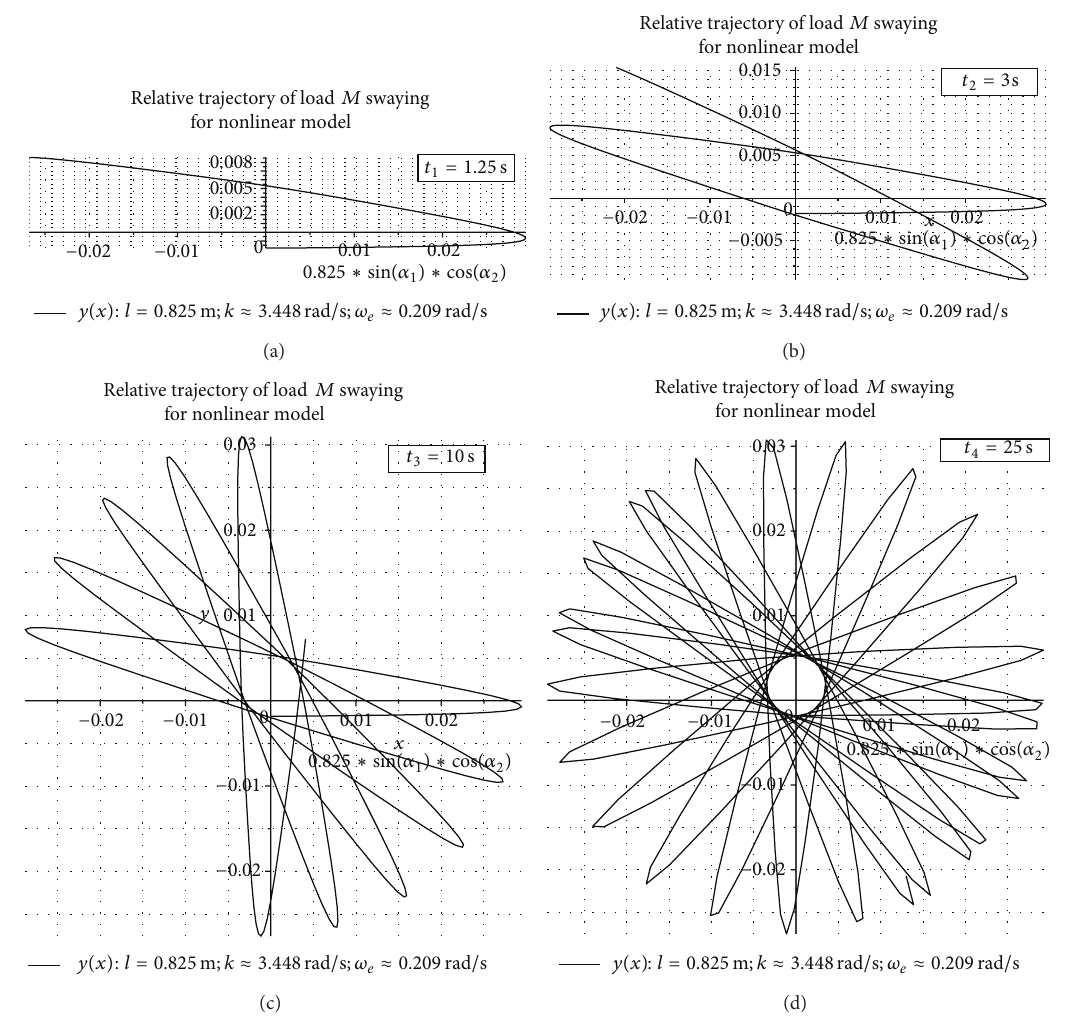
Figure 16: The relative trajectories for load 𝑀 swaying on the cable during uniform rotational motion of the crane boom 𝐵𝑂 2 for the moments of times 𝑡 1 = 1.25 s (a), 𝑡 2 = 3 s (b), 𝑡 3 = 10 s (c), and 𝑡 4 = 25 s (d), derived with nonlinear model introduction.